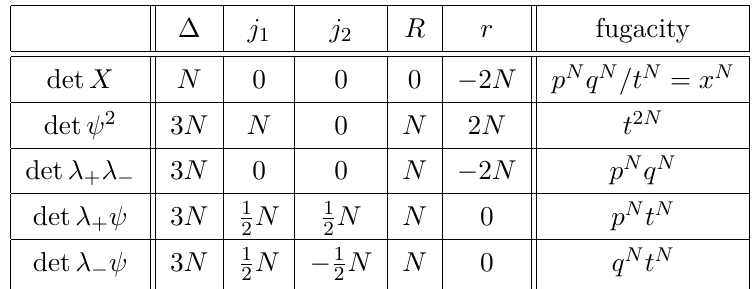
Table 4 . Charges of determinant operators in the N = 2